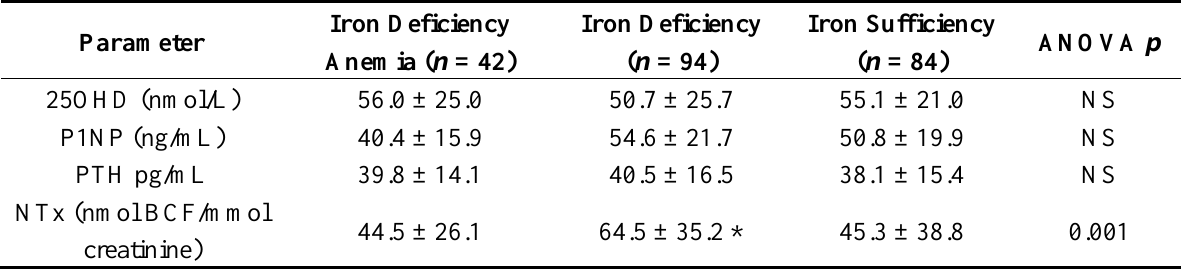
Table 6. Bone biomarkers in iron deficiency anemia, iron deficiency, and iron sufficiency groups.